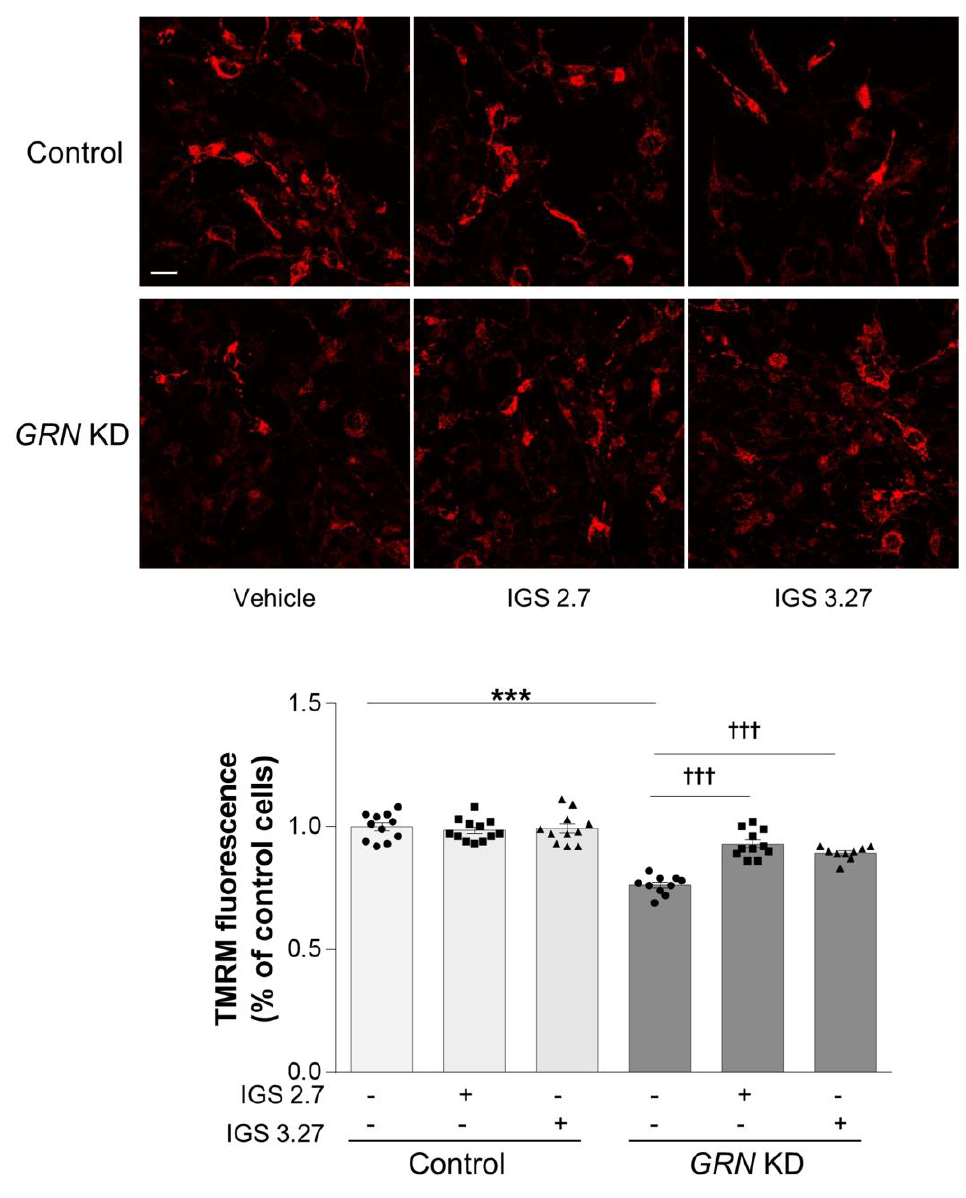
Figure 5. Treatment with pTDP-43 inhibitors rescues mitochondrial impairment in GRN KD SH-SY5Y cells. Control and GRN KD SH-SY5Y cells were seeded at the same confluency in coverslips and treated with 5 µ M of two pTDP-43 inhibitors (IGS2.7 and IGS3.27) for 48 h. Mitochondrial membrane potential was measured by assessing TMRM fluorescence using a confocal microscope with 40 × water-immersion objective (Ex/Em = 549/575 nm). Scale bar = 9 µ m. Top panel shows representative images of TMRM staining in control and GRN KD cells before and after the treatment with both pTDP-43 inhibitors. Plot represents the average ± SEM of at least eleven images for each condition. The experiment was performed three times. Statistical analysis was performed using two-way ANOVA´s tests followed by Bonferroni´s correction. *** p < 0.001 significant difference between untreated control and GRN KD cells. ††† p < 0.001 significant difference between untreated and treated GRN KD cells.